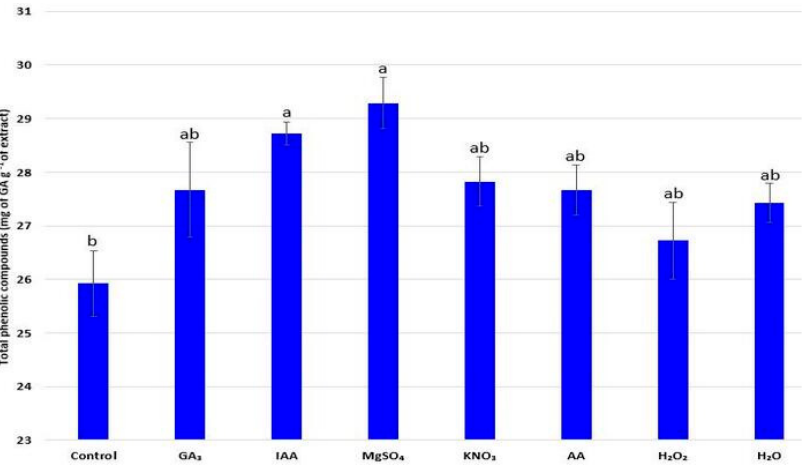
Figure 4. Influence of different priming treatments on concentration of total phenolic compounds (mg of GA g − 1 of extract) in the aboveground part of radish ( R. sativus ) seedlings; the values represent the means of six replicates ± standard error. Different letters indicate significant differences ( p ≤ 0.05) between treatments according to Tukey’s test.